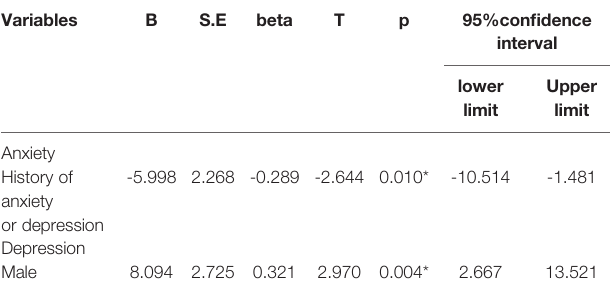
TABLE 5 | Linear regression analysis for anxiety and depression in doctors.